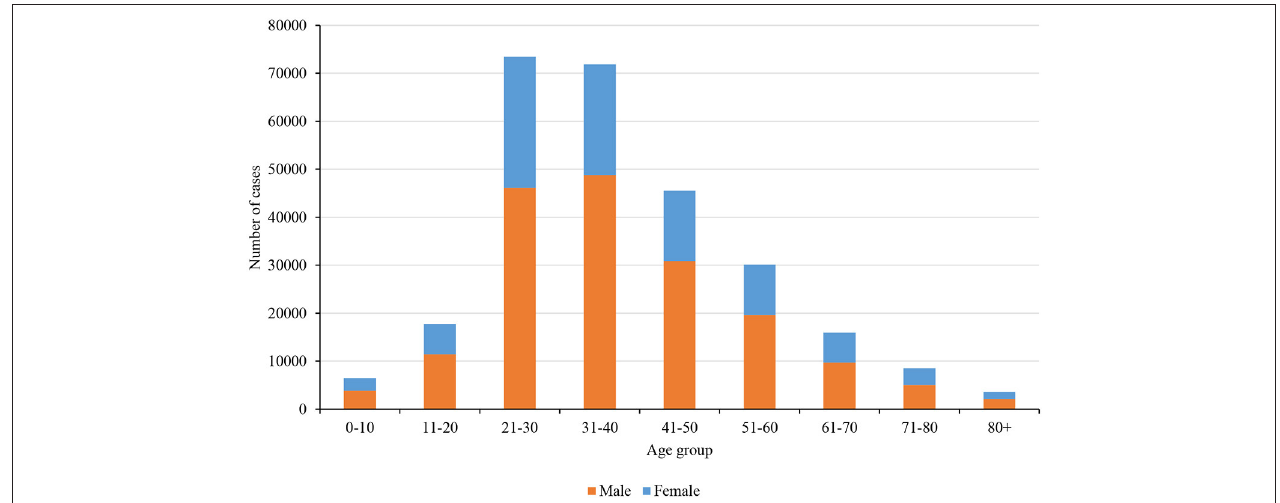
FIGURE 9 | COVID-19 cases distribution among age group and gender as of 01 March 2021.